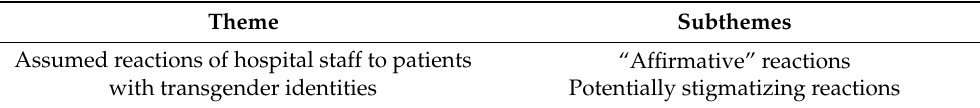
Table 3. Assumed reactions of hospital staff to patients with transgender